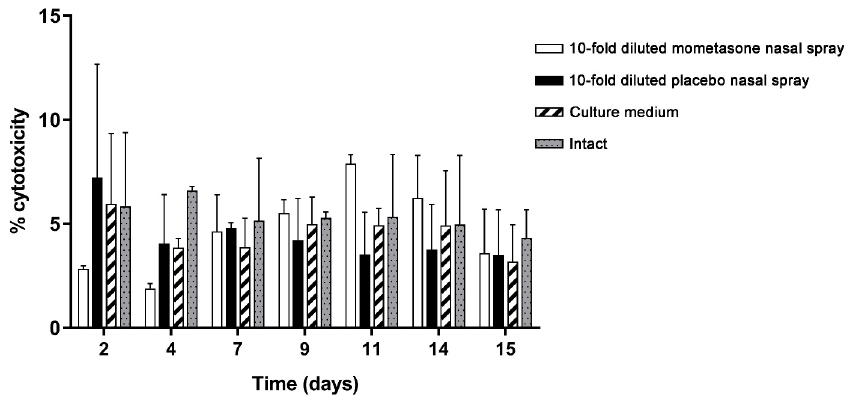
Figure 6. Lactate dehydrogenase (LDH) cytotoxicity assay of repeated doses of 10-fold diluted mometasone and placebo nasal spray, culture medium or intact condition on the nasal MucilAir TM in vitro model. The results are expressed as a percentage of cytotoxicity relative to the maximum LDH activity (of RPMI 2650 cells). Bars represent mean ± S.E. of two independent experiments. Two-way ANOVA with Tukey’s multiple comparisons test was performed. No statistical dif- ferences in cytotoxicity between the treated and untreated nasal in vitro models were observed.